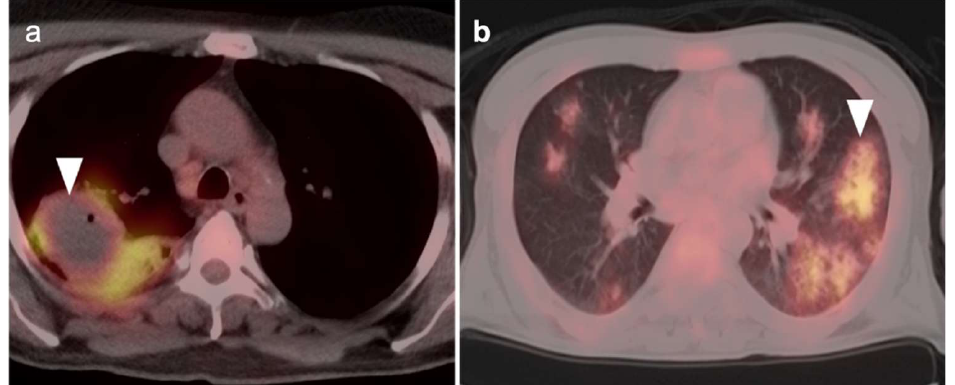
Figure 4. Pulmonary infection in two patients: ( a ) Case 1: Axial FDG PET-CT image demonstrates hypermetabolic consolidation in the right lower lobe with an associated peripherally hypermetabolic parenchymal fluid collection containing air consistent with pneumonia and a lung abscess ( white arrowhead ). There is also ipsilateral paratracheal mildly hypermetabolic reactive adenopathy; ( b ) Case 2: Multifocal ground glass consolidations ( white arrowhead ) in a patient with COVID-19 pneumonia. Both findings could mimic thoracic malignancy.